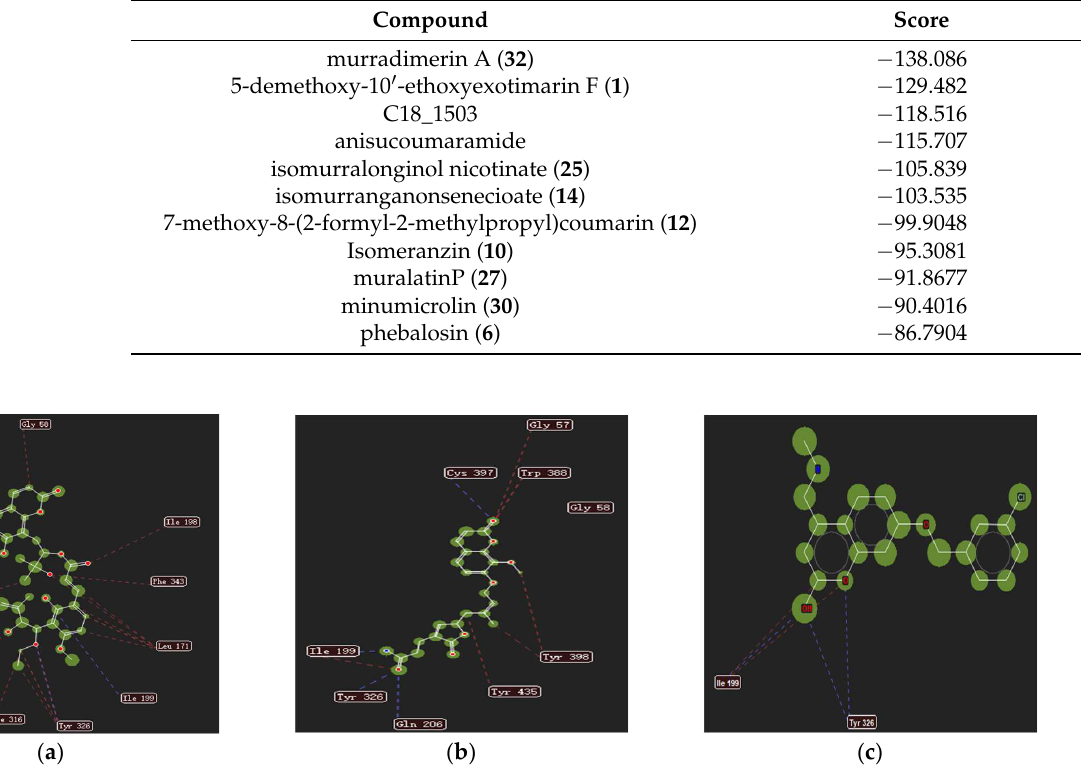
Table 3. Docking scores of coumarins of Murraya exotica L.